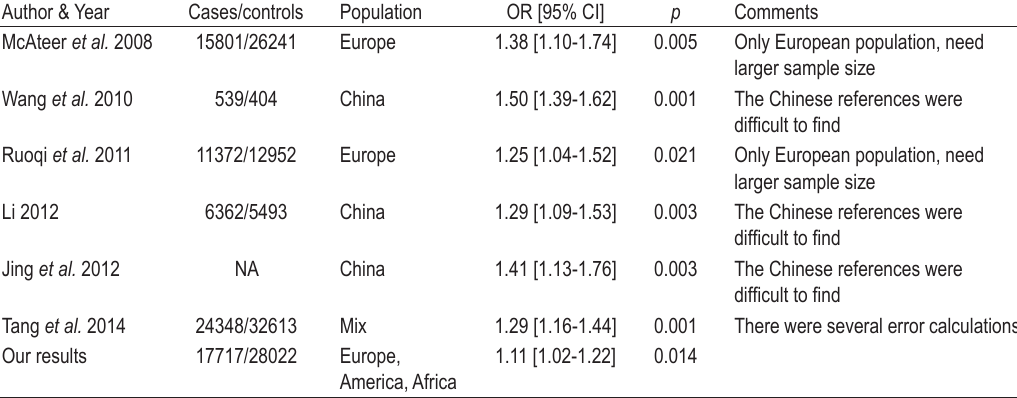
TABLE 3. Summary of meta‑analysis studies regarding the association between the ENPP1 K121Q gene polymorphism and the risk of T2DM in different